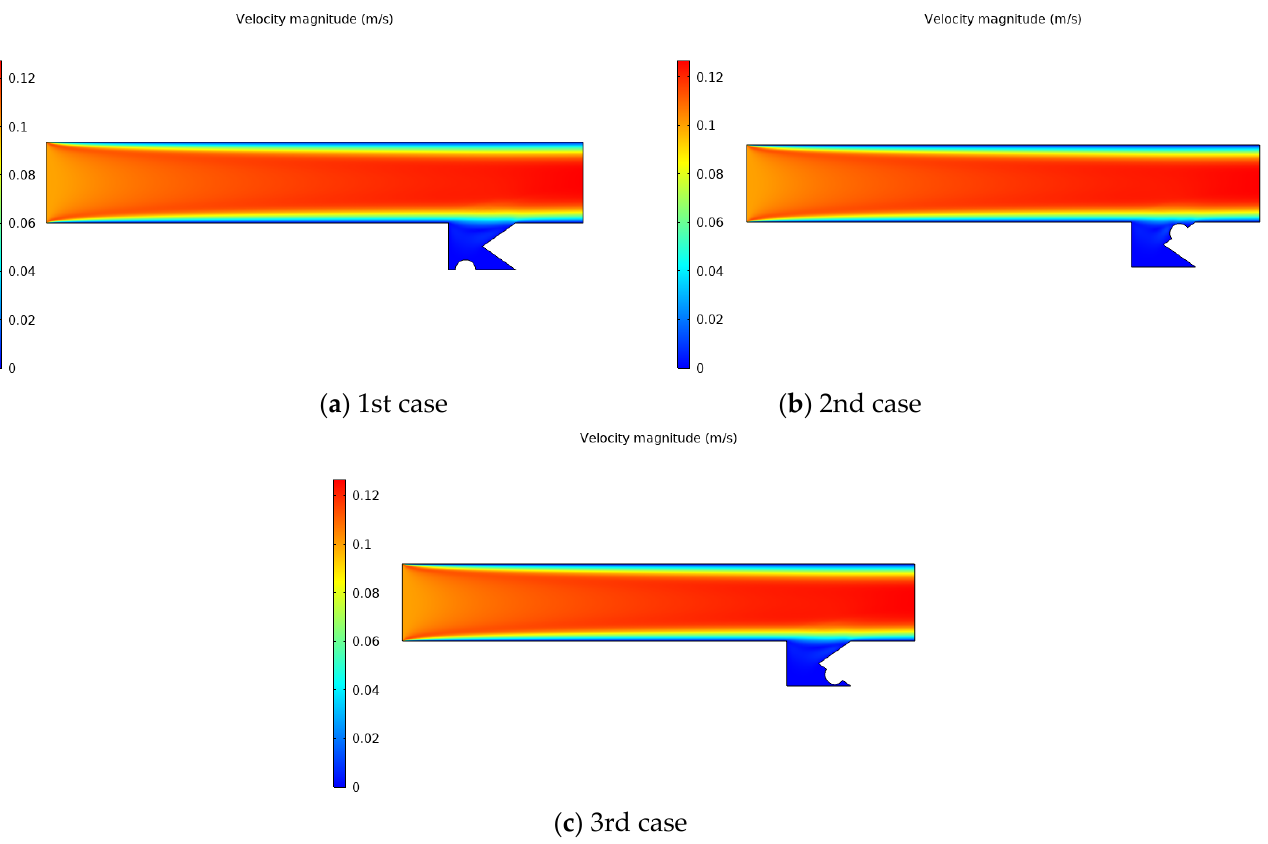
Figure 5. 2D Velocity contours . Figure 5.